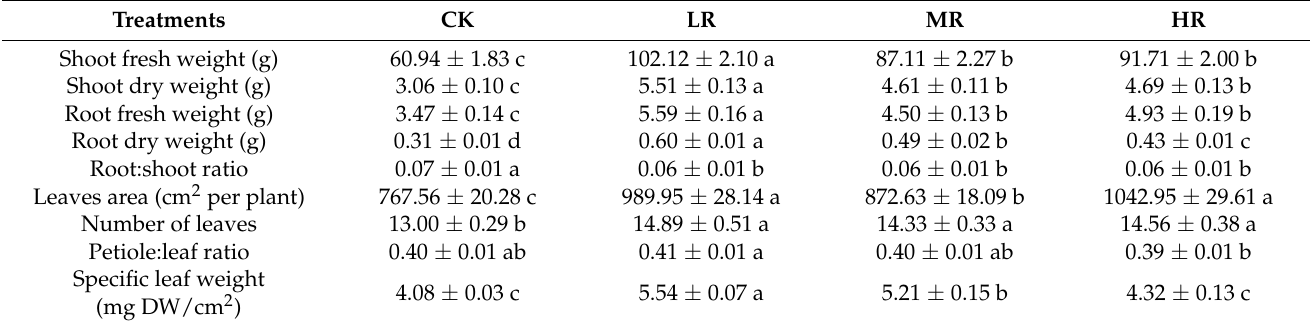
CK: only white light, LR: red:white = 1:2, MR = red:white = 1:1, LR = red:white = 2:1. All values in the table are expressed as mean ± standard error ( n = 9). Different letters in the same row indicate significant differences between treatments by Duncan’s multiple range test ( p ≤